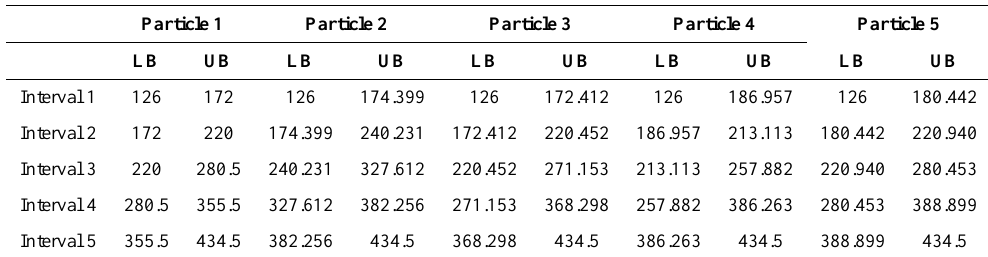
Table 21. PSO random particles